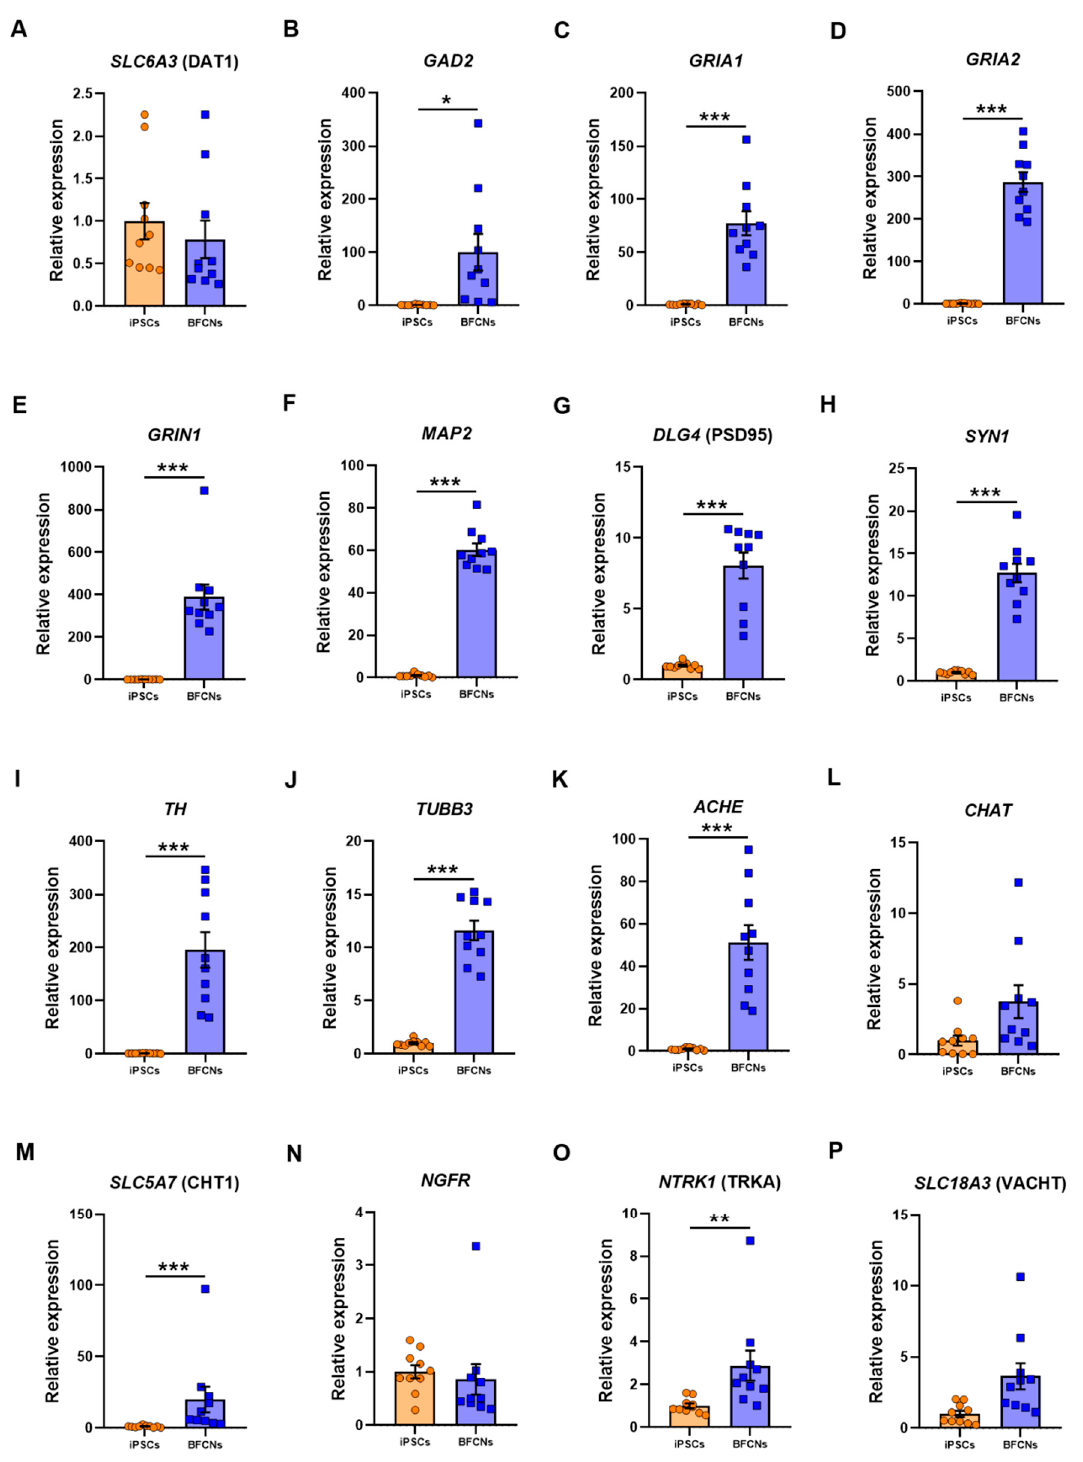
Figure 4. Expression of neuronal and specific BFCN markers in iPSC and BFCN cultures. The iPSC and BFCN samples were analysed by nCounter (Nanostring) and, after normalisation of total amount of RNA molecules to the housekeeper genes, results are shown as fold change of BFCN cultures over iPSCs. Analysis of the neuronal markers ( A ) SLC6A3 (DAT1), ( B ) GAD2 , ( C ) GRIA1 , ( D ) GRIA2 , ( E ) GRIN1 , ( F ) MAP2 , ( G ) DLG4 (PSD95), ( H ) SYN1 , ( I ) TH and ( J ) TUBB3 ; and the specific BFCN markers ( K ) ACHE , ( L ) CHAT , ( M ) SLC5A7 (CHT1), ( N ) NGFR , ( O ) NTRK1 (TRKA) and ( P ) SLC18A3 (VACHT). Data are derived from 10 iPSC lines and 10 BFCN di ff erentiated samples from 1 independent di ff erentiation for each line. Individual data are shown. Histogram bars represent mean values and error bars represent S.E.M. Graphs show * p ≤ 0.05, ** p ≤ 0.01, *** p ≤ 0.001, by two-tailed t -test except in A, D, E, G, L, M, N, O and P that Kolmogorov-Smirnov test was used for non-parametric